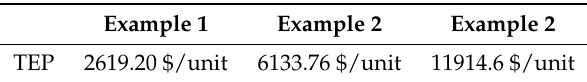
Table 8. Comparative Study.